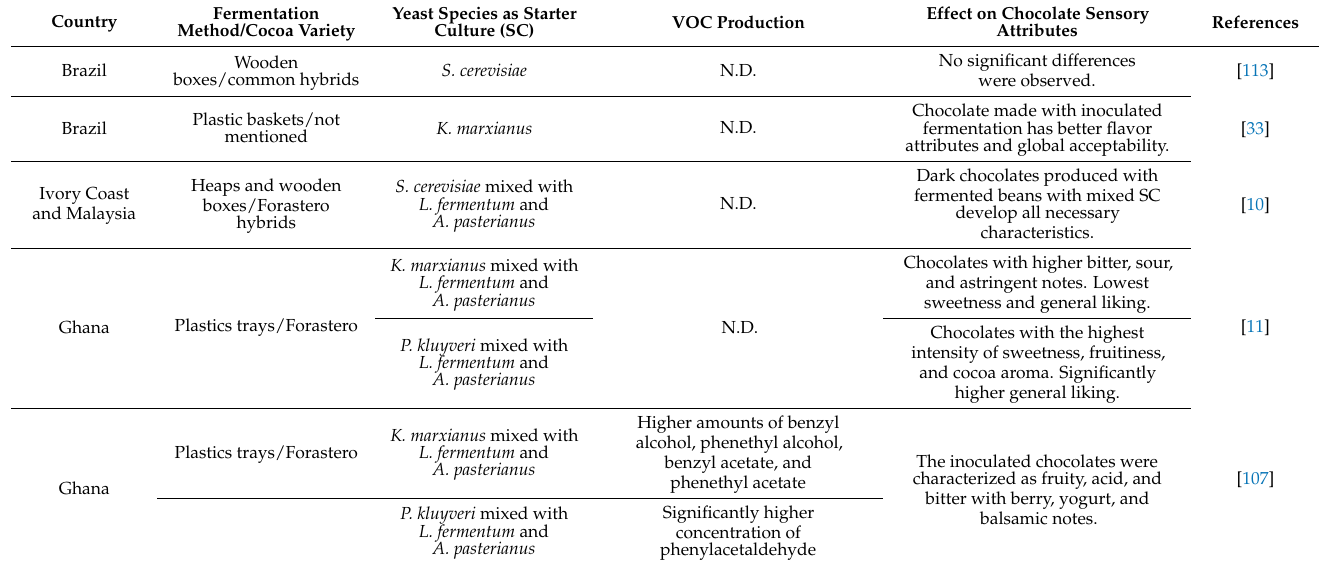
Table 2. Yeasts are used as starter cultures during cocoa bean fermentation and their effects on VOC production and sensory attributes on chocolates. Comparisons are made with spontaneous fermentation